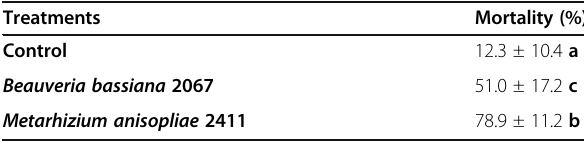
Table 2 Percentage of Diaphorina citri mortality with different treatments under semi-field